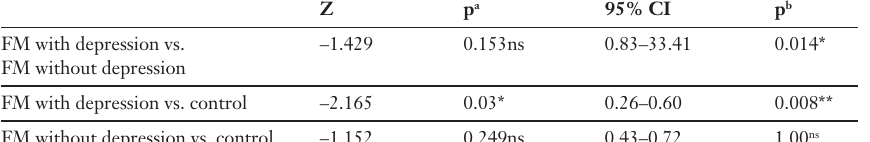
Statistical analysis of study